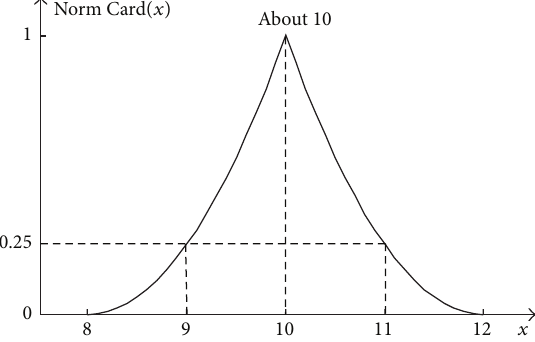
Figure 21: 2D distribution of the full 4D solution of the fuzzy equation 𝐴 + 𝑋 = 𝐶 in a form of the cardinality distribution of particular 𝑥 values, 𝑥 ∈ [ 8 , 12 ]